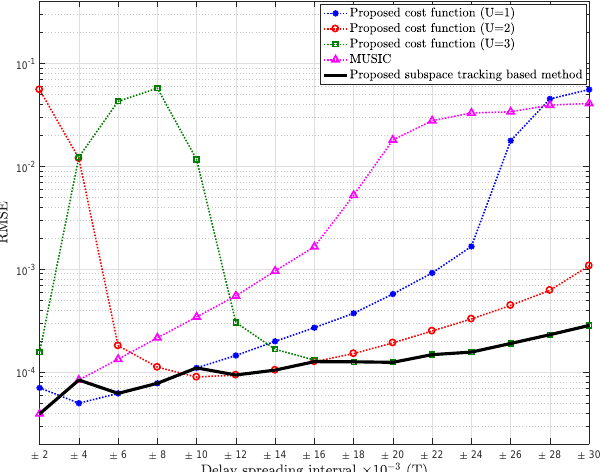
Figure 8. RMSE of mean delay estimation vs. delay spreading of the proposed cost function for U = 1, U = 2 and U = 3, the proposed subspace tracking-based method, and MUSIC; L = 2, t = [ 0.37 0.51 ] T , P l = 20, K = 64, SNR = 15